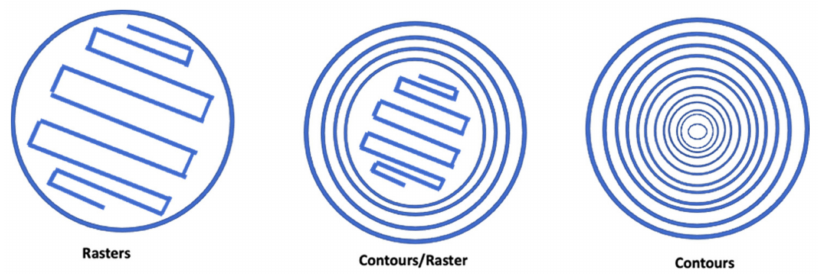
Figure 4. Types of infill